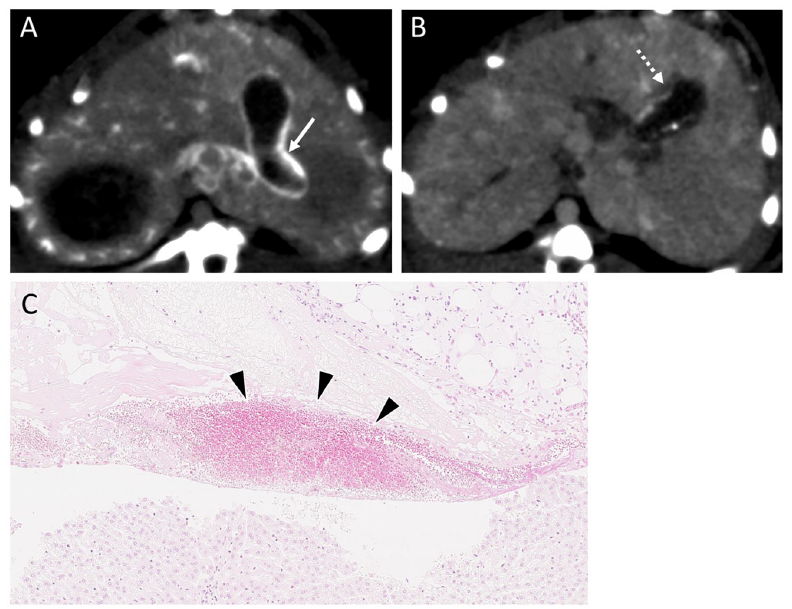
Fig 8. A case of cholecystitis following TACE. (A) Diffuse Lipiodol accumulation in the gallbladder wall, as observed in a CT scan, immediately after TACE (white arrow). (B) Lipiodol retention in the gallbladder wall, as well as thickening of the wall, two days after TACE (white dashed arrow). (C) Infiltration of inflammatory cells into the gallbladder wall, which is indicative of cholecystitis (black arrowheads).